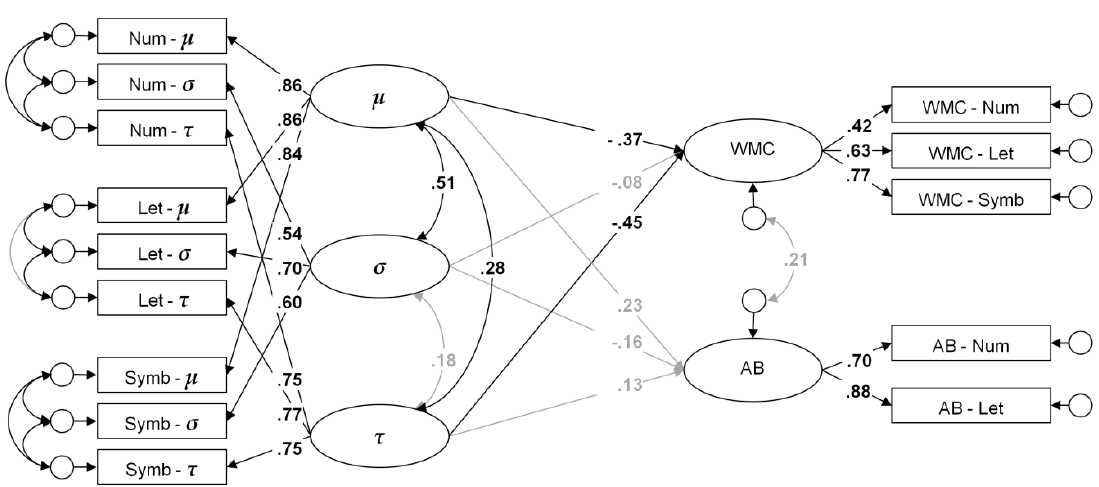
Figure 5. Parameters of the ex-Gaussian parameterization fitted to the Substitution tasks as predictors of WMC and AB. Significant parameters are displayed in black font.